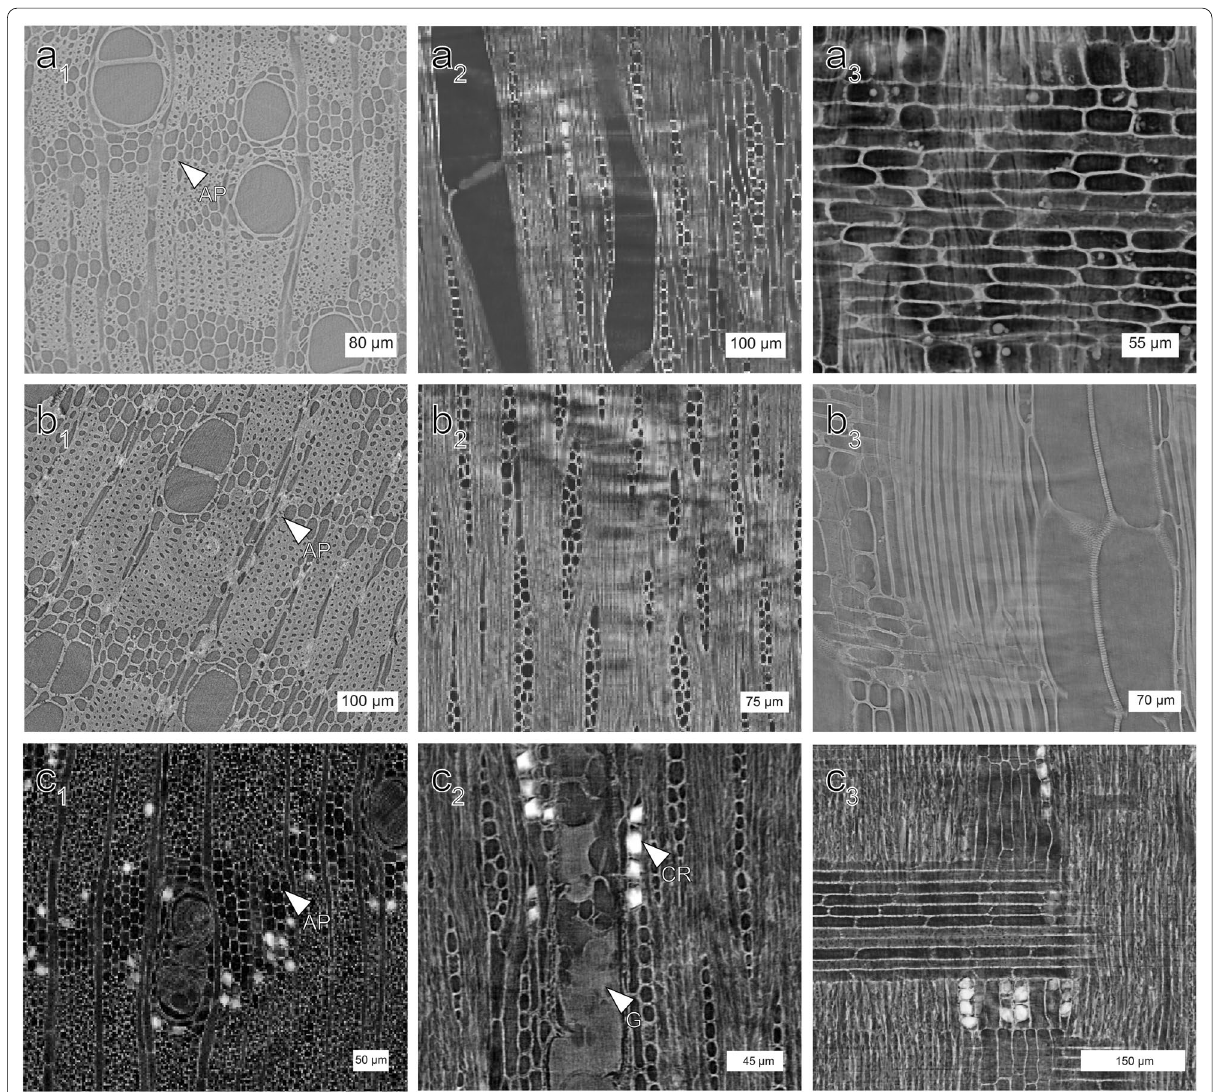
2 ), and radial section ( a 3 , b 3 , c 3 ). AP axial parenchyma, CR prismatic crystal, G